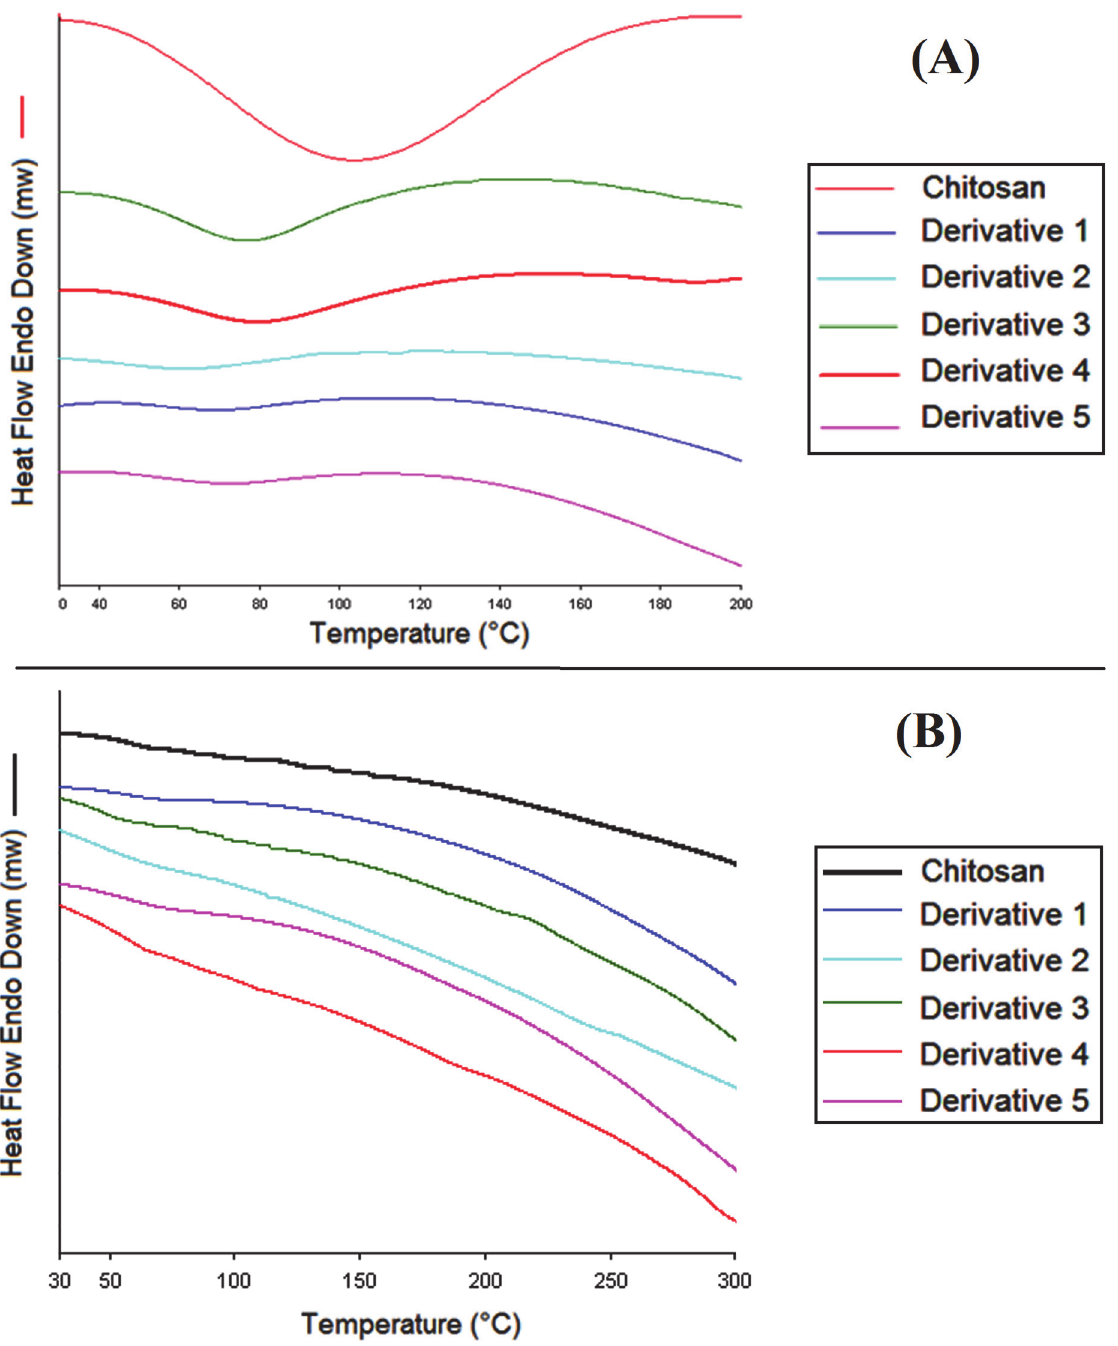
Fig 5. DSC of chitosan and derivatives. (A) First DSC curve of chitosan and derivatives obtained at a heating rate of 10 °C /min and (B) Second DSC curve of dry chitosan and derivatives obtained at a heating rate of 10 °C /min/.